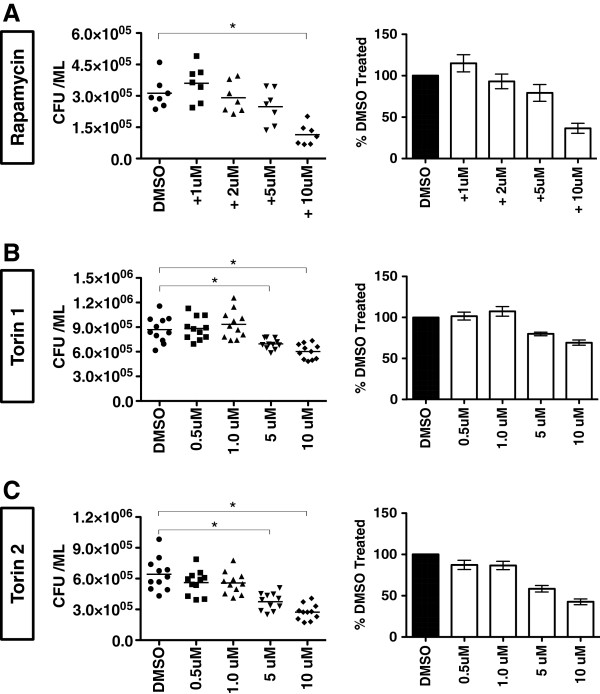
Low doses of Rapamycin, Torin 1, and Torin 2 are insufficient to kill M. smegmatis. RAW264.7 cells were infected with M. smegmatis and treated with Rapamycin (A), Torin 1 (B), or Torin 2 (C). Cells were then lysed and plated for CFU determination. Shown are combined results of two independent assays performed with each inhibitor. On the left are the raw CFU values for each replicate. On the right is the percentage change (+/− SEM) from the mean value of cells treated with DMSO that was set at 100%. For the comparison of raw CFU values, asterisks indicate p ≤ 0.05 for drug treated groups versus DMSO treated cells.